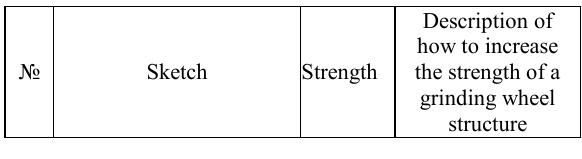
Table 1. Grinding wheel